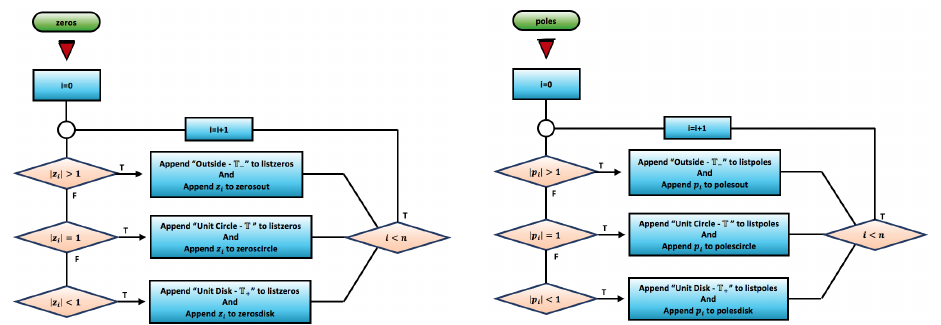
Figure 39. Flowcharts of the [AZeros] and [APoles] algorithms.